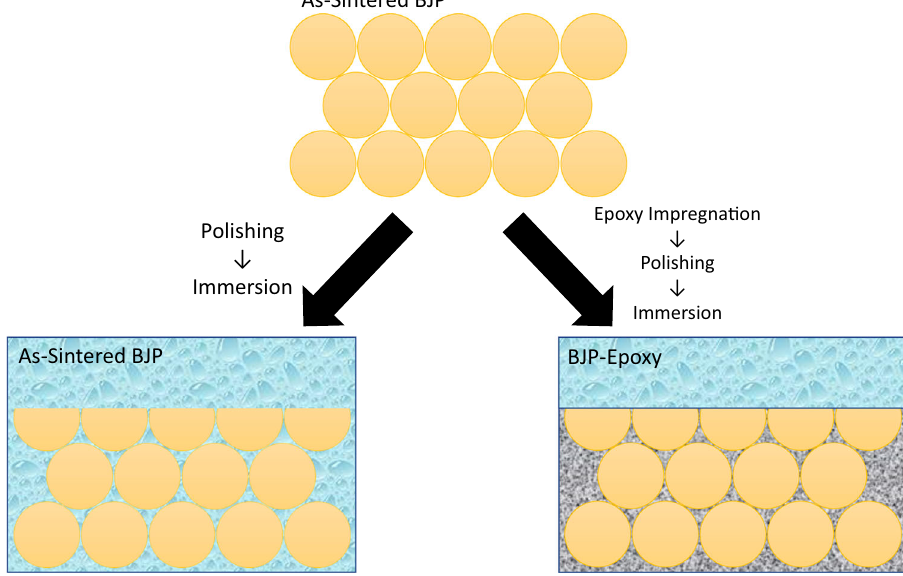
Fig. 4 Corrosion of porous BJP alloy with and without epoxy preparation. Schematic of the cross-section view, showing the difference between the corrosion surface of the as sintered BJP porous structure in contact with the electrolyte with and without epoxy impregnation.